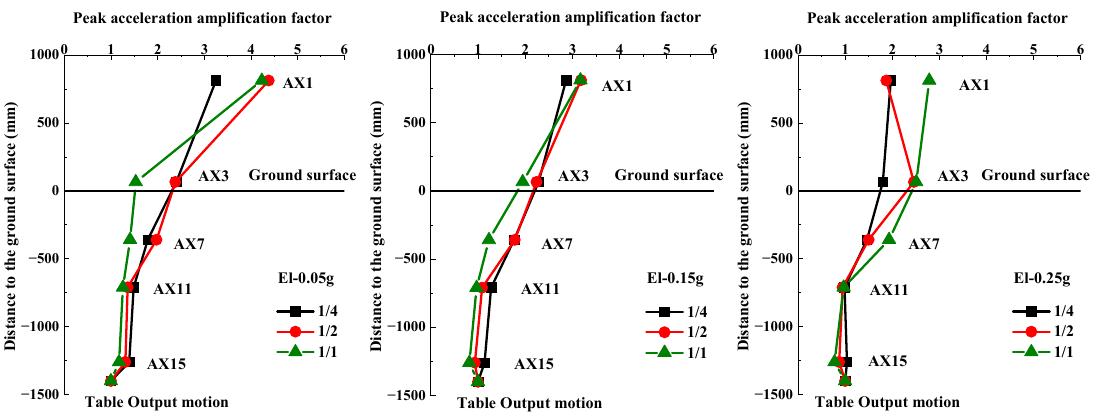
Figure 16. The peak acceleration amplification ratio of the structure under scaled El Centro records.